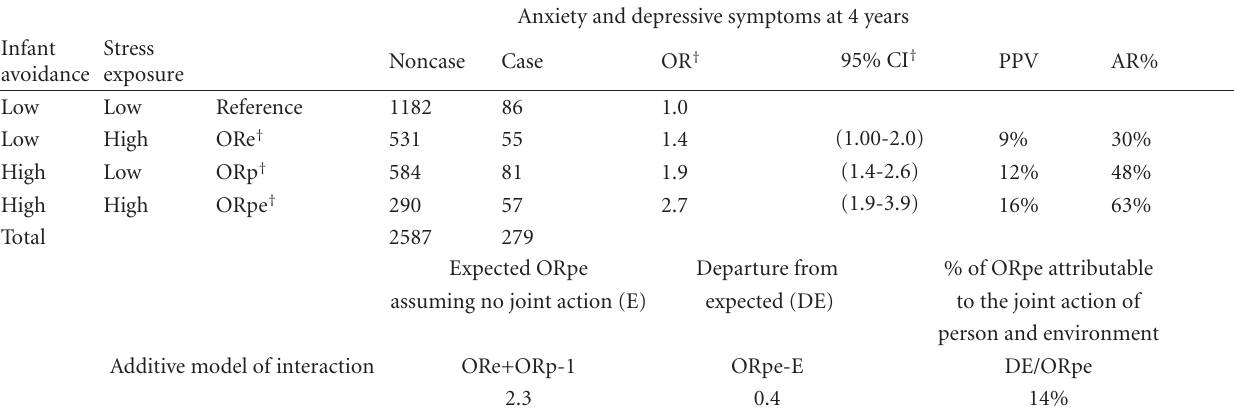
Table 4: Odds ratios for anxiety and depressive symptoms at age 4 years attributable to person-environment interaction between early life stress and avoidant temperament style.